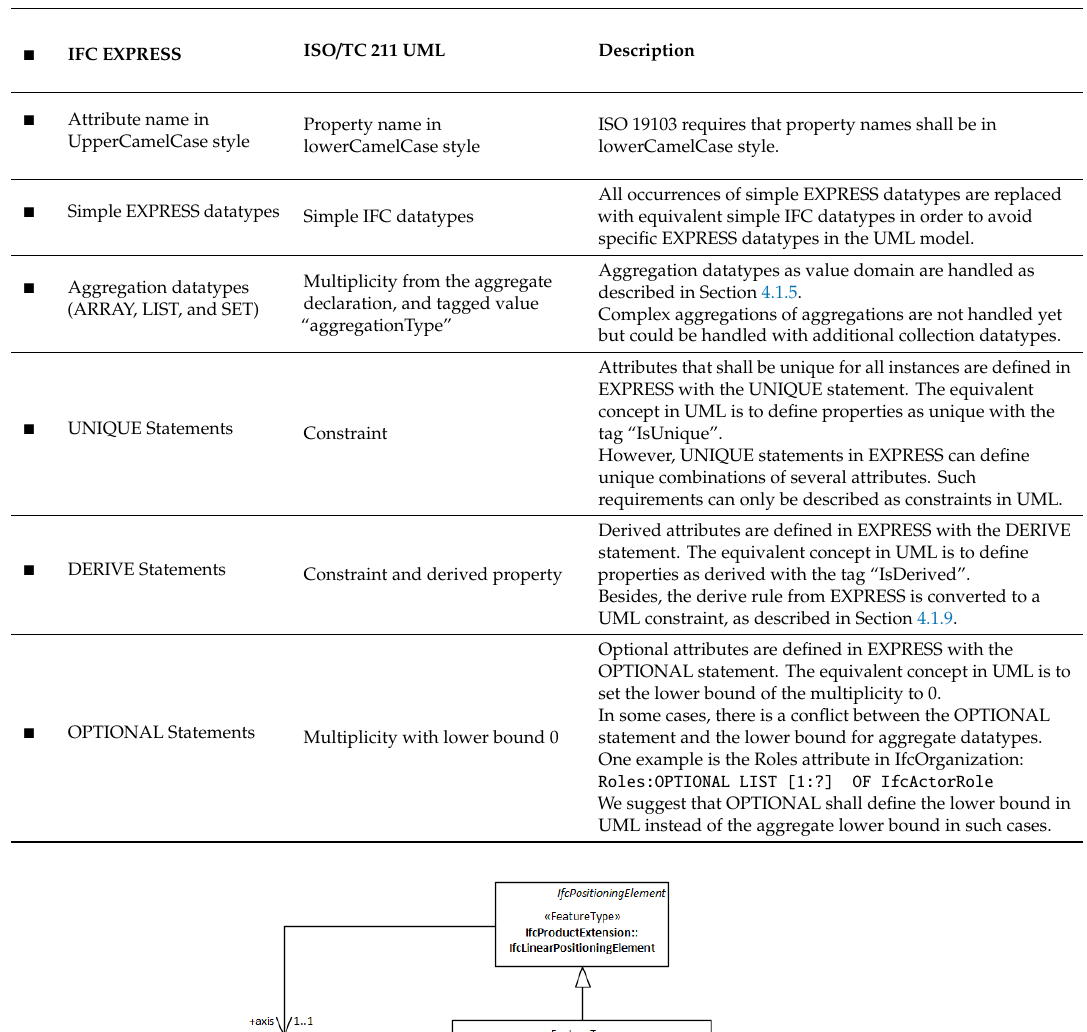
Table 7. Conversions pattern for attributes.